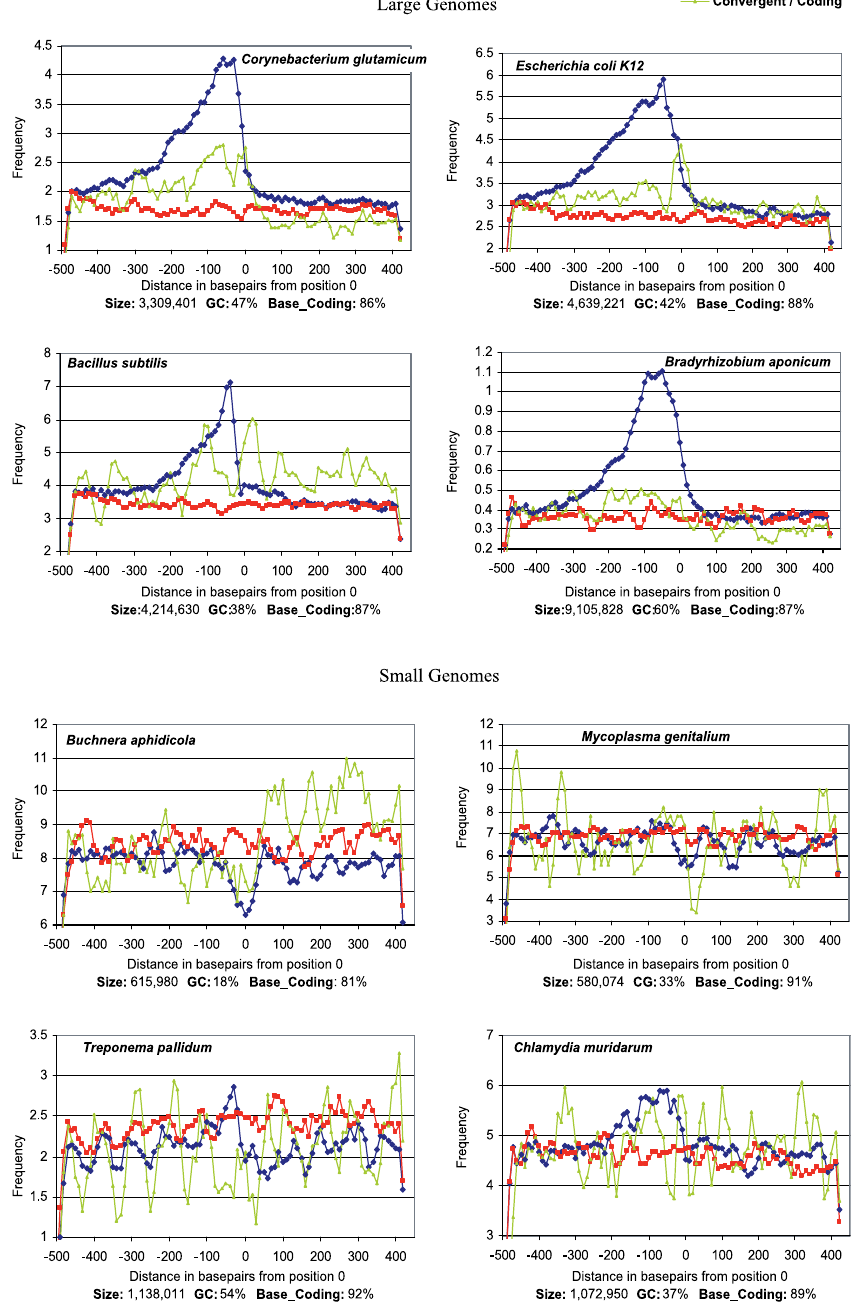
Figure 3. Signal Density in Regulatory versus Nonregulatory Regions of Large and Small Eubacterial Genomes Regulatory regions correspond to the strictly noncoding regions located upstream of a gene start. For the set of genomes selected in this study, the average size of the strictly noncoding upstream regions is 182 bp. For the sake of the graph, the regions were extended to 500 bases upstream and 500 bases downstream of the start of the gene (position 0). Nonregulatory regions include the coding regions and the noncoding regions between convergently transcribed genes. For coding regions, the middle point of a gene was taken as the position 0 and 500 bases upstream and 500 bases downstream of this position were included. For the set of genomes analyzed here, the average size of the convergent regions is 194.5 bp. For the sake of the graph, the end of the 3 9 gene was taken as position 0 and 500 bases upstream and 500 bases downstream of this position were included. The number of signals was averaged within intervals of 10 bp. finding that promoter-like sequences in these organisms theoretical results demonstrating that the effectiveness of show a certain degree of degradation reflected in their selection is diminished in the small, highly structured decreased scores for the (cid:1) 10 and (cid:1) 35 motifs (Table 2), populations of host-restricted bacteria [11–17]; (iv) the suggesting an overall reduction of the efficiency of selection